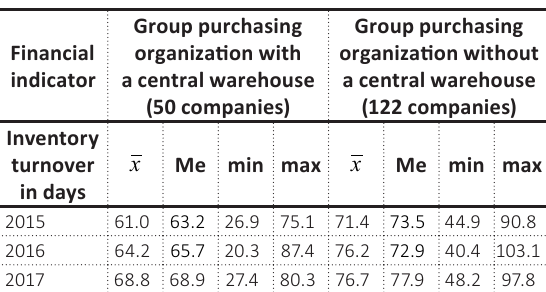
Table 2. Average results of inventory turnover